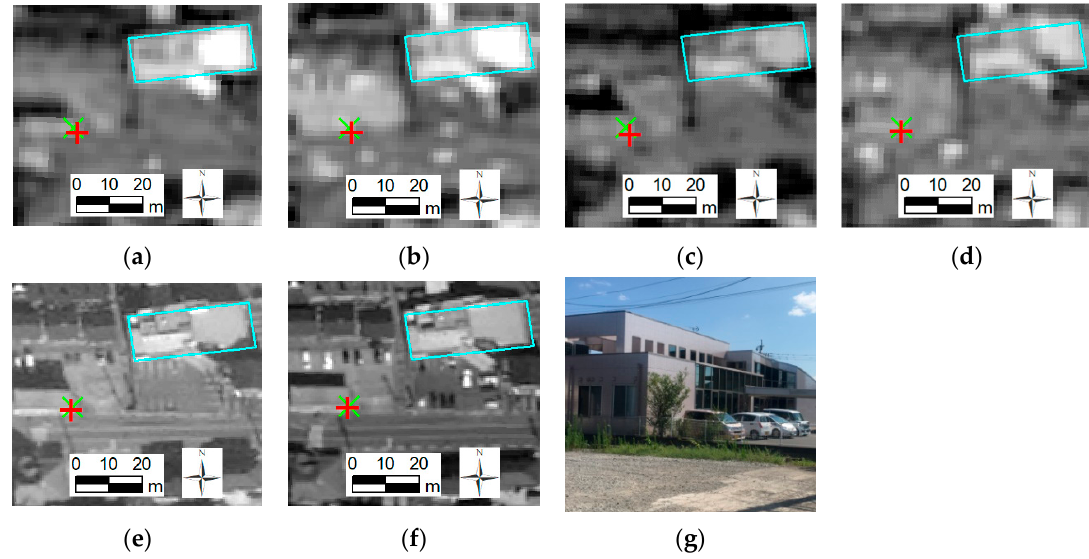
Figure 6. Geometric evaluation of the orthorectified satellite imagery data. The GPS measured position (green X), the position of the building corner in images (red +), and the building footprint of the OSM data is overlaid on a ( a ) SPOT image on 20 March 2016; ( b ) SPOT image on 29 July 2016; ( c ) SPOT image on 1 January 2017; ( d ) SPOT image on 25 March 2018; ( e ) Pleiades image on 1 January 2017; and ( f ) Pleiades image on 13 October 2018. ( g ) Picture of the building from the position that the GPS measured toward the building outlined footprint of the OSM data.